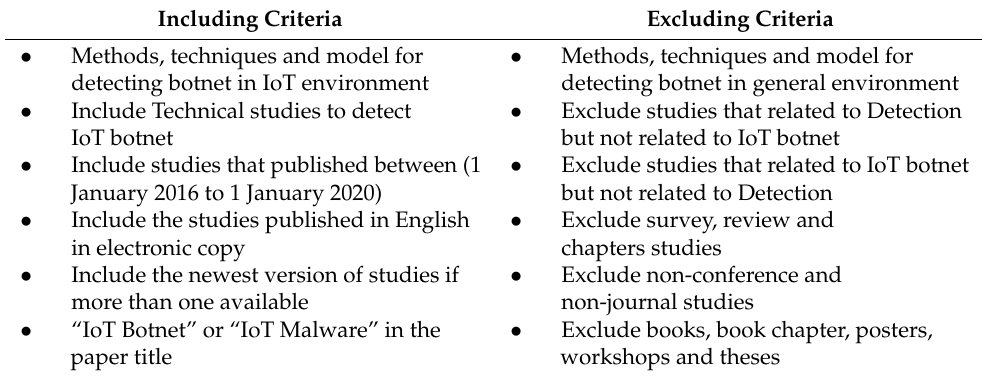
Table 5. Inclusion and exclusion criteria for